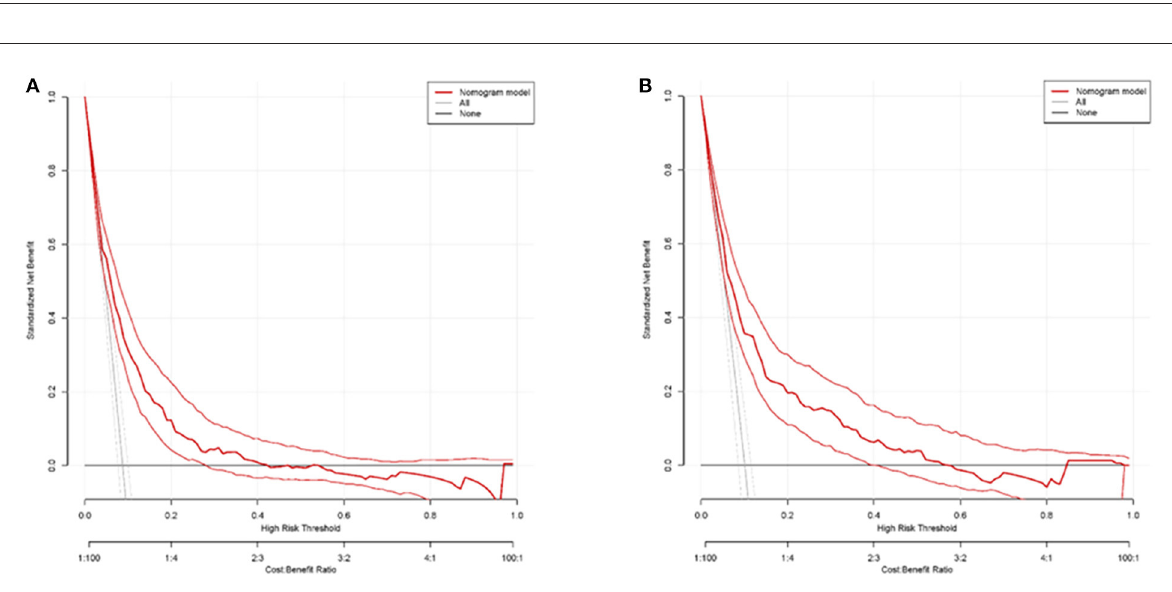
FIGURE5 Decision curve analysis (DCA) of the nomogram model for predicting 1-year all-cause mortality in training set (A) and validation set (B) . The abscissa shows the threshold probability of 1-year all-cause mortality prediction, and the ordinate represents the net benefits of benefits and hazards. The black parallel horizontal line above the abscissa indicates that none of the patients died, and the net benefit is 0. The gray line indicates that the 1-year all-cause mortality occurred in all